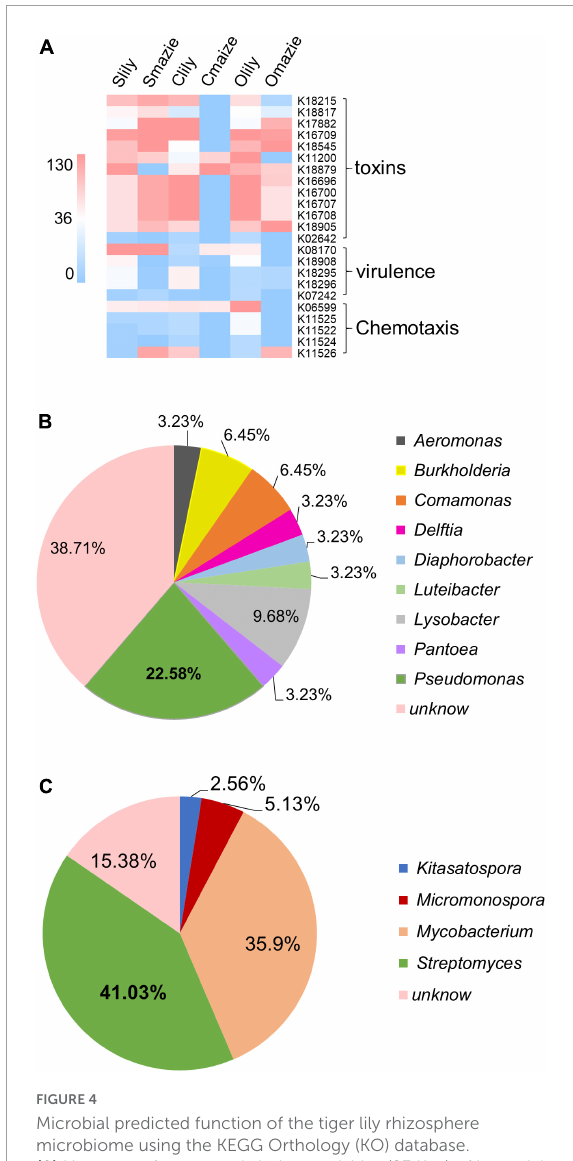
FIGURE4 Microbial predicted function of the tiger lily rhizosphere microbiome using the KEGG Orthology (KO) database. (A) Heatmap of conserved virulent activities (23 Kos) of bacterial communities in tiger lily rhizosphere within the three different soil types. Color scale indicates bacterial abundance. (B) Distribution of the bacteria of 23 KOs at genus level within the Gammaproteobacteria class. (C) Distribution of the bacteria of 23 KOs at genus level within the Actinobacteria